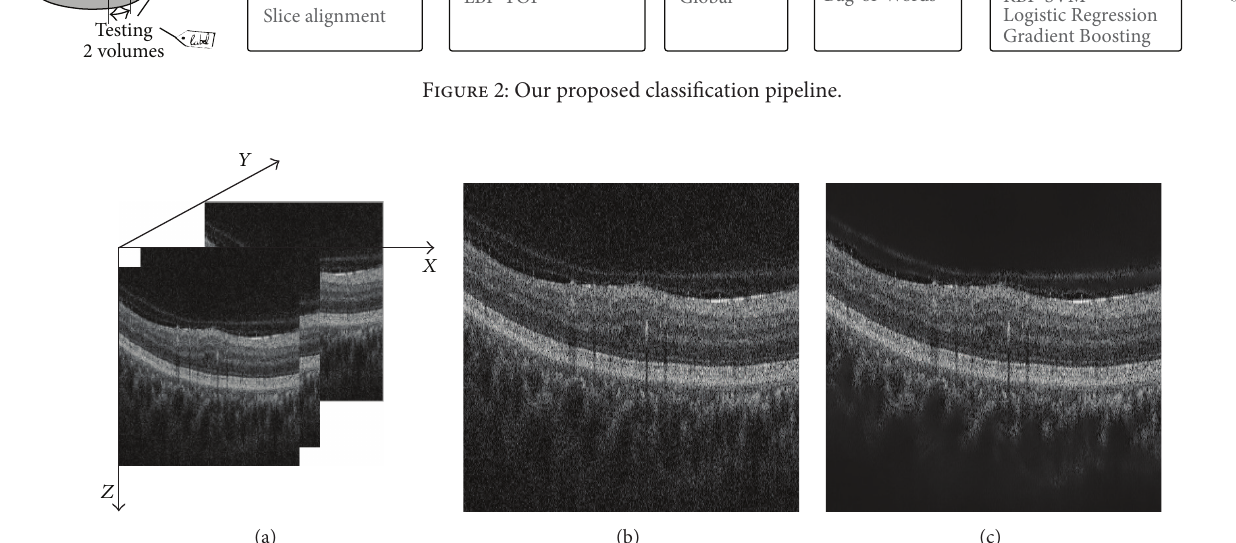
Figure 3: OCT: (a) organization of the OCT data, (b) original image, and (c) NLM filtering. Note that the images have been negated for visualization